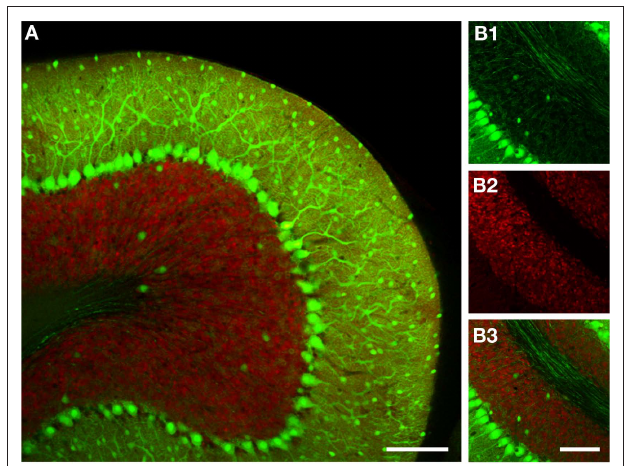
FIGURE 3 | The use of fl uorescent protein color variants to genetically defi ne multiple cell populations. (A) A confocal image of a cerebellar slice from a transgenic mouse expressing GFP and EYFP via the GAD 67 and Kv3.1 promoters respectively. Images were acquired with a 32-channel spectral resolution on a Nikon C1si system and deconvoluted with GFP and EYFP spectra. The resulting GFP and EYFP signals are shown in green, and red false colors to enhance contrast. In (B) are shown images with larger magnifi cation of the separate channels demonstrating the very high resolution that can be achieved with genetic approaches (note individual Purkinje cell axons). (B1) shows only GFP fl uorescence highlighting the dense axonal network formed by the Purkinje cells and interneurons, whilst in (B2) only EYFP is visible in the numerous small granule cells, fi nally (B3) shows both channels. Scale bar throughout: 100